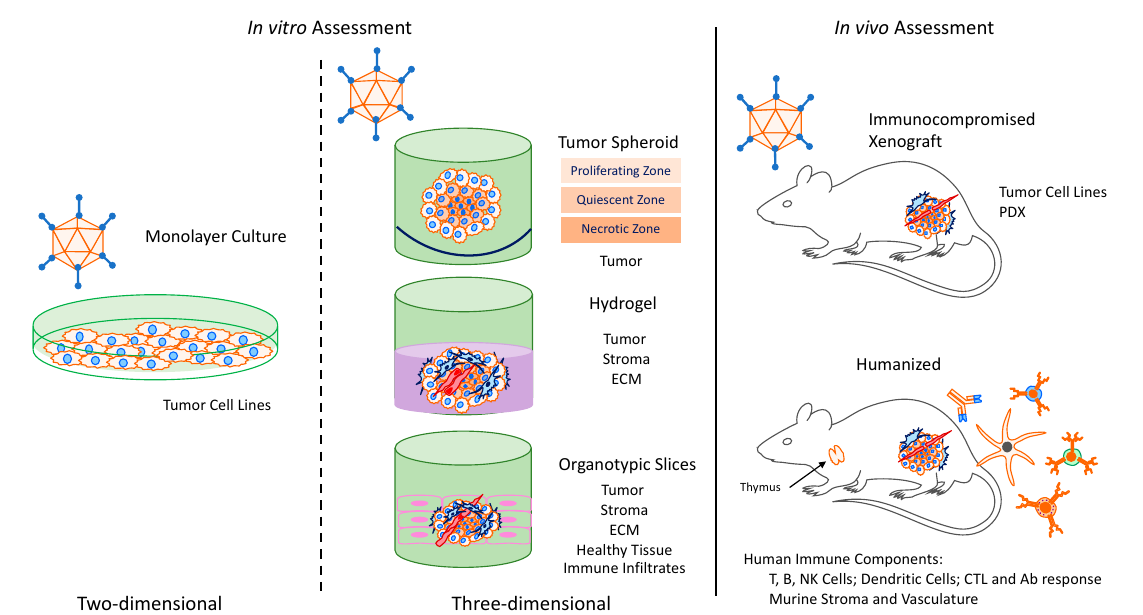
Figure 1. Preclinical models of oncolytic adenovirus.